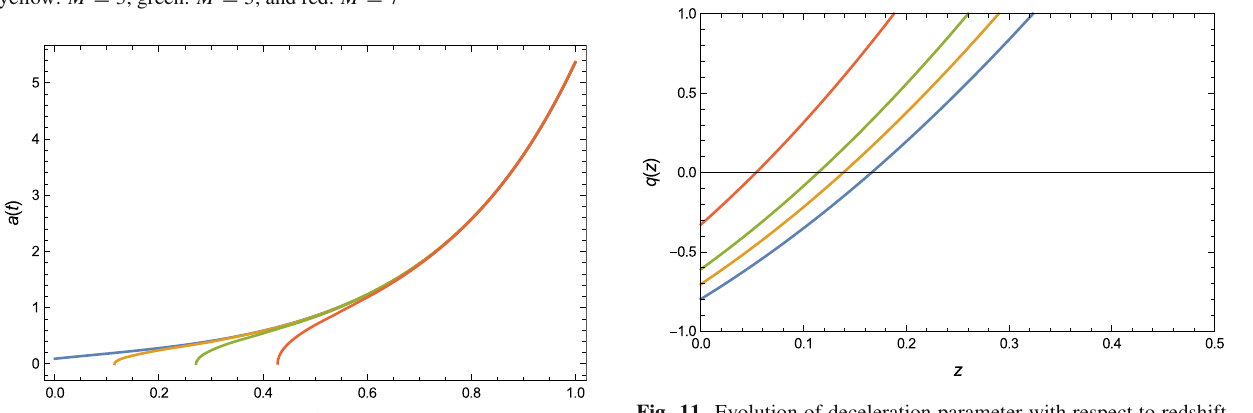
Fig. 11 Evolution of deceleration parameter with respect to redshift. The corresponding values of the mass term, M , are the same as in Fig.